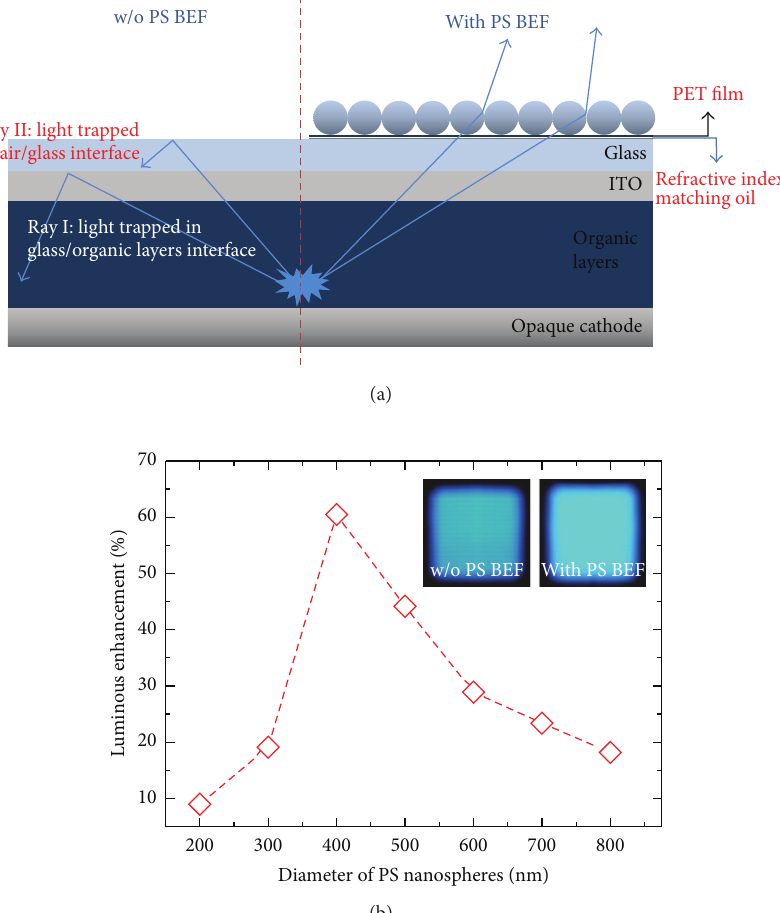
Figure 5: (a) Light extraction of trapped photons in glass substrate and organic layer of bottom emission OLED and (b) luminous enhancement of OLED devices attached with 2D photonic crystal pattern structures of various nanosphere diameters ranging from 200 to 800